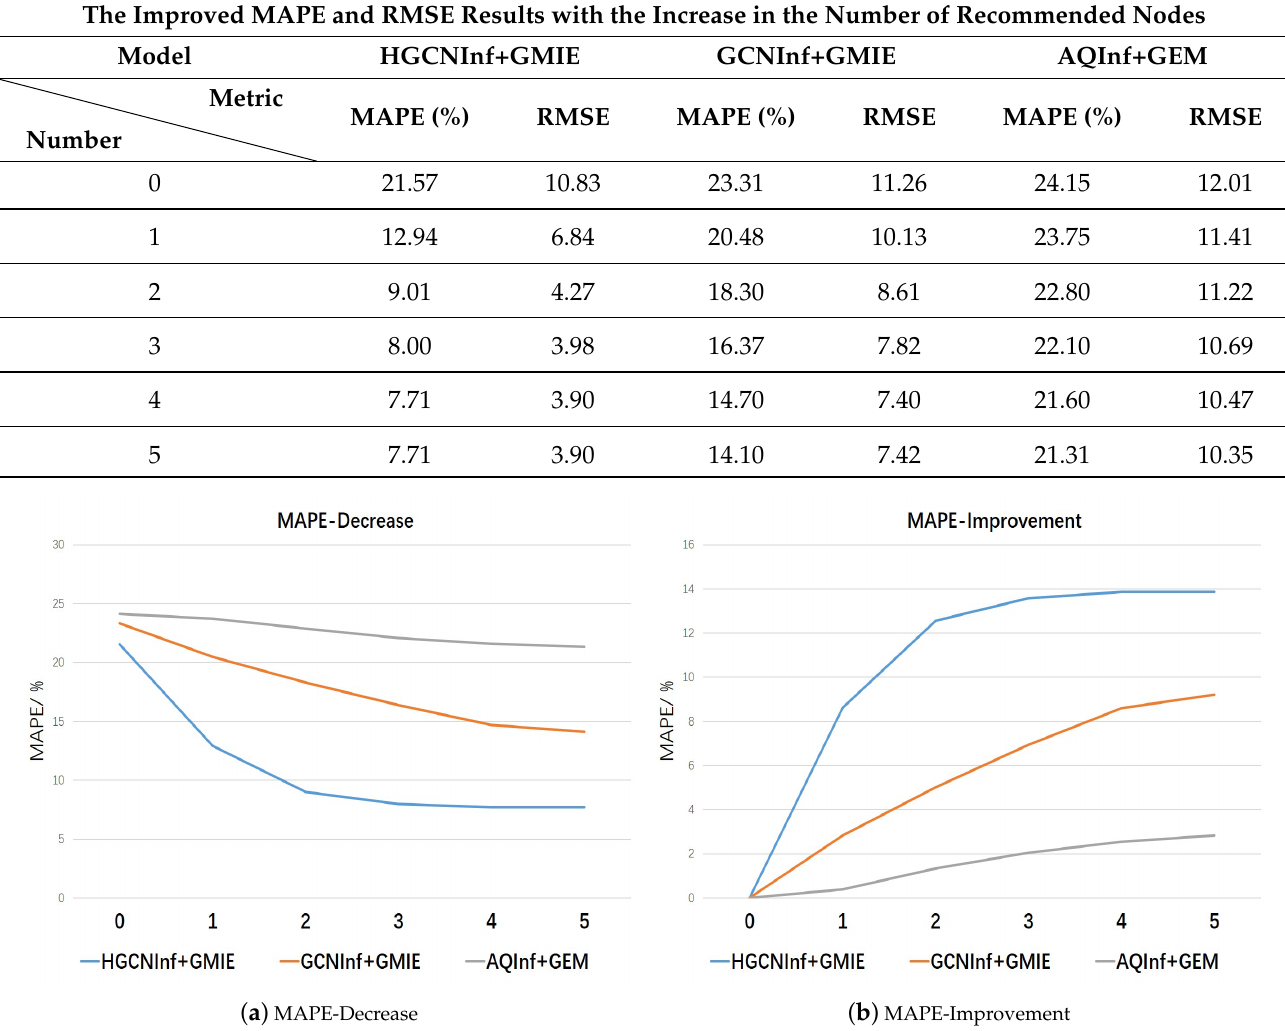
Table 6. The improved MAPE and RMSE results with varying numbers of recommended locations. The Improved MAPE and RMSE Results with the Increase in the Number of Recommended Nodes